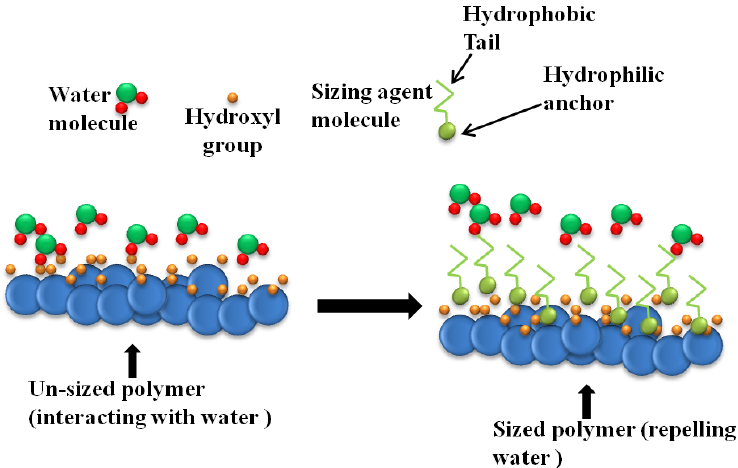
Figure 1. Sizing agent molecules orientation, redrawn from [50].